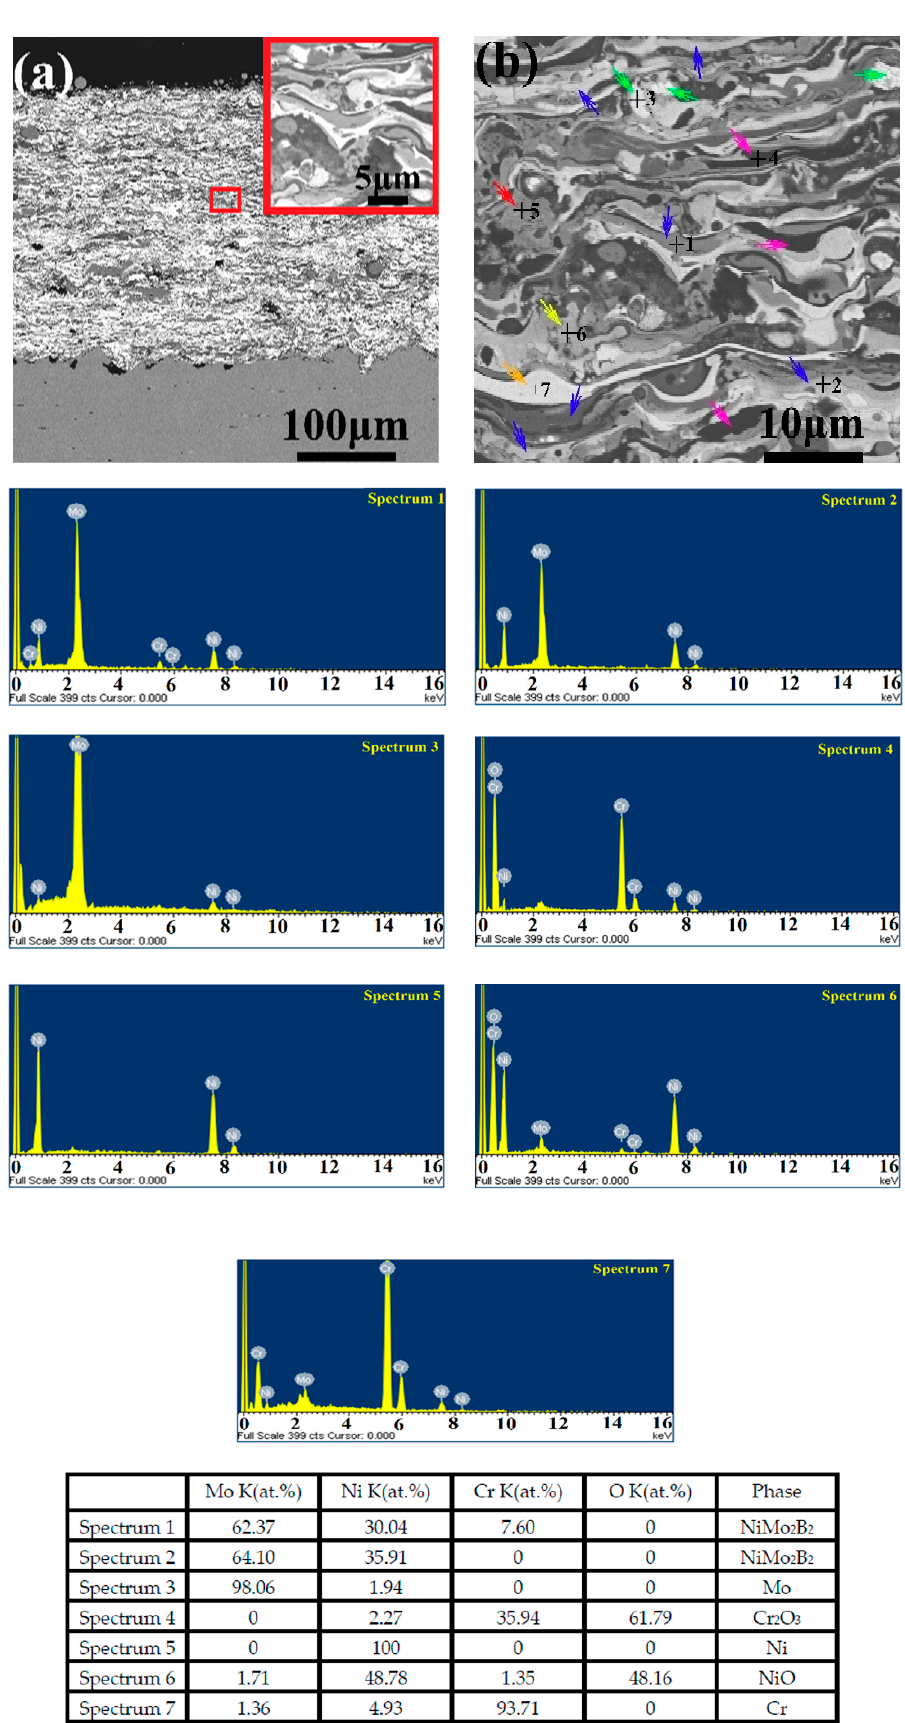
Figure 11. Cross-sectional morphologies and compositions of the MoB/CoCr coating: ( a ) 500×, and ( b ) 10000×.